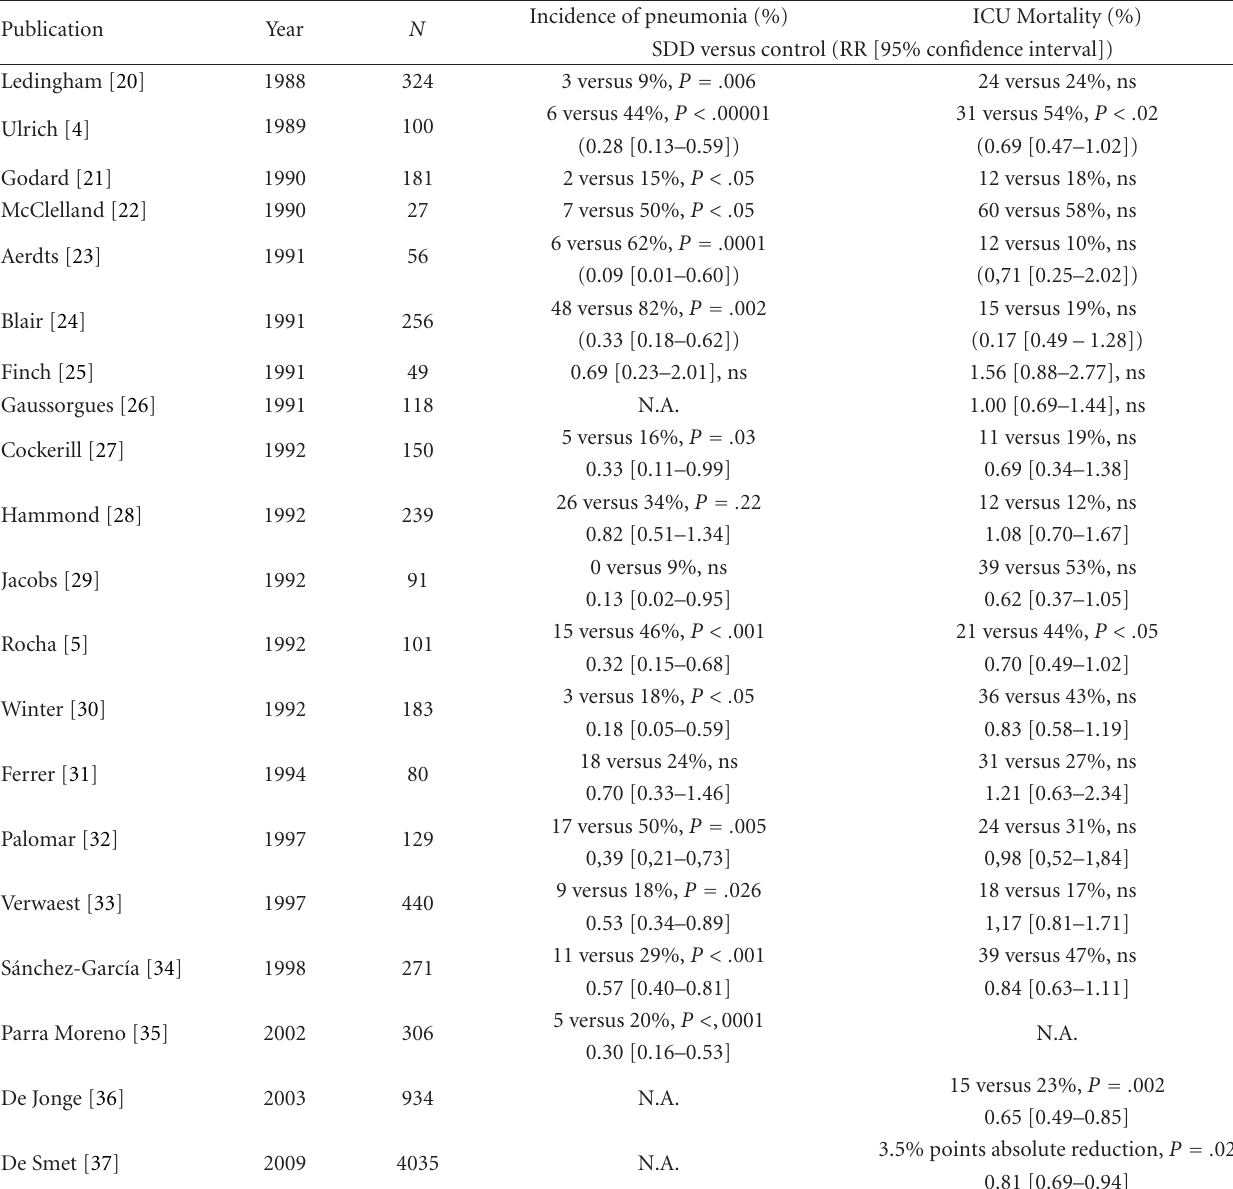
Table 2: Incidence and relative risks of pneumonia and mortality in trials of SDD in mixed medical-surgical